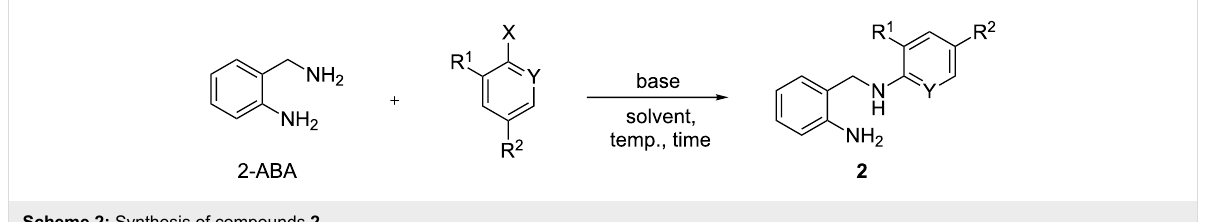
Scheme 2: Synthesis of compounds 2